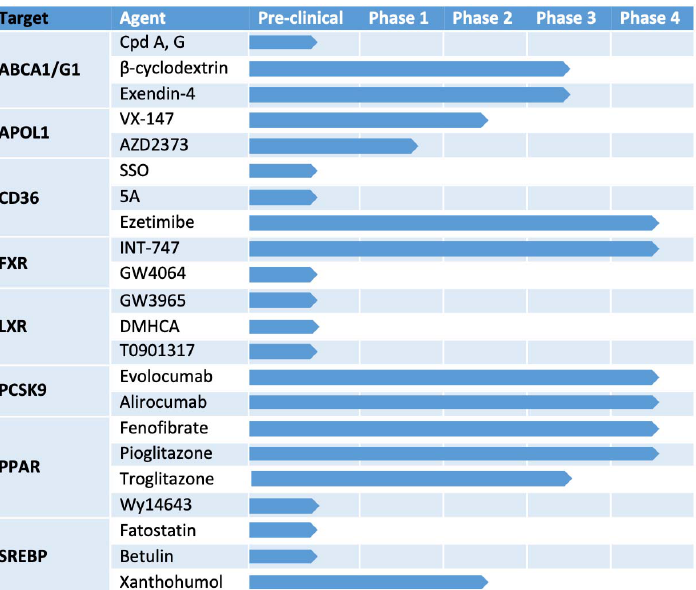
Figure 2. The status of different drugs under development that target lipid metabolism. ABCA1/ ABCG1: ATP binding cassette subfamily A/G member 1; APOL1: Apolipoprotein L1; CD36: cluster of differentiation 36; FXR: farnesoid X receptor; LXR: liver X receptor; PCSK9: pro-protein convertase subtilisin/kexin type 9; PPAR: proliferator-activated receptor; SREBP: sterol regulatory element- binding